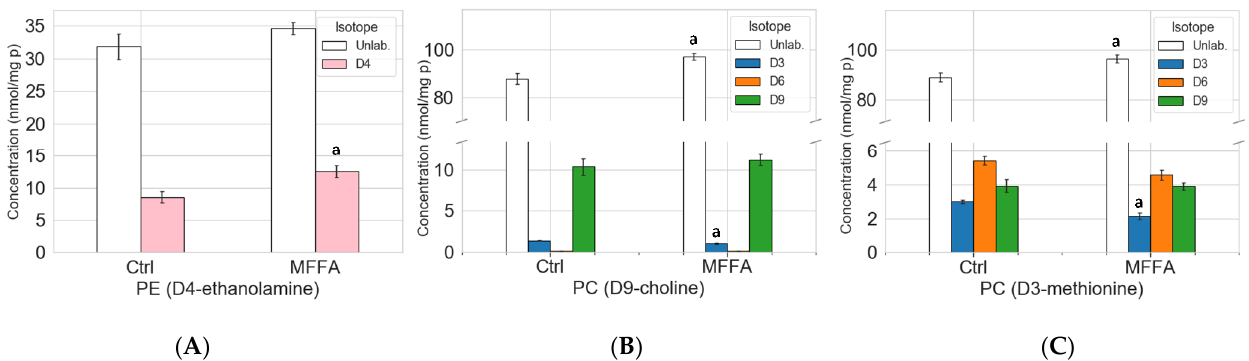
Figure 4. Isotopic labeling profiles for PE and PC in control and MFFA-treated hepatocytes. Isolated rat hepatocytes were treated without (Ctrl) or with 2 mM of MFFA in special DMEM media of which a nutrient has been replaced with its deuterated version (50 μM D4-ethanolamine, 30 μM D9-choline or 200 μM D3-methionine), serving as a flux tracer for phospholipid biosynthetic pathways, for 6 h. The cells were then harvested and underwent lipid extraction, followed by lipidomic analysis. ( A ) shows the concentrations of unlabeled (unlab.) and D4-labelled (D4) PE in the D4-ethanolamine labelling experiments (Data shown as mean ± sem; pink: D4-labelled PE; a: p < 0.05 vs. corresponding D4-labelled PE in Ctrl group, Mann-Whitney U test, n = 4). ( B ) and ( C ) show the concentrations of the unlabeled (unlab.) and D3, D6, and D9-labelled (D3, D6, and D9) PC in D9-choline and D3-methionine labelling experiments, respectively. (Data shown as mean ± sem; discrete Y -axis; blue: D3-labeled PC; orange: D6-labeled PC; green: D9-labeled PC; a: p < 0.05 vs. corresponding unlabeled/labeled PC in Ctrl group; Mann–Whitney U test; n = 3 for D9-choline and D3-methionine experiments).